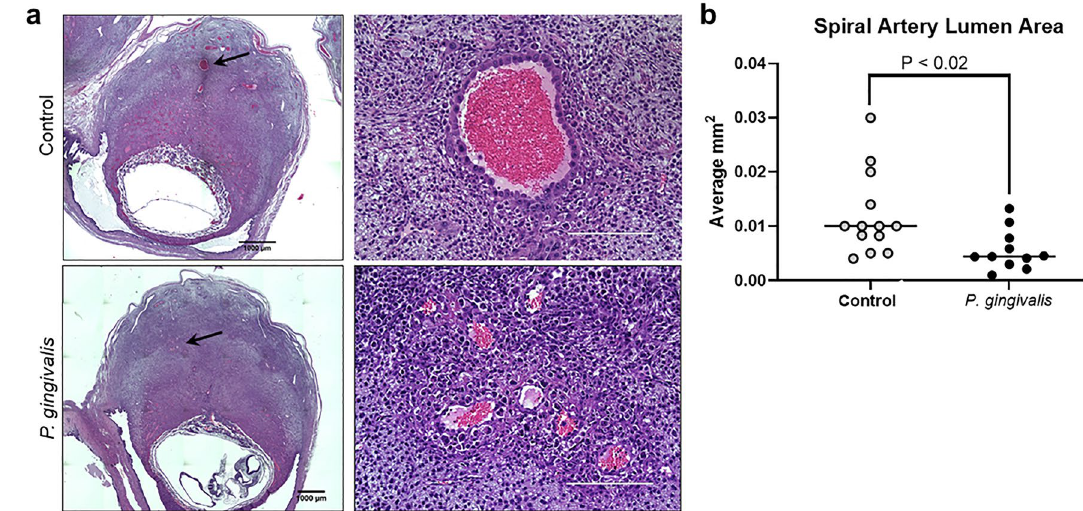
Figure 2. Impact of P. gingivalis infection on GD11 spiral artery lumen size. ( a ) Representative images from control and P. gingivalis -infected specimens. Left panels are tiled composites of individual pictures taken at × 10 magnification with an EVOS Auto FL imaging system. Scale bar = 1000 µm. Black arrows mark the spiral artery segments pictured in the corresponding right panels. White scale bar = 200 µm. ( b ) Spiral artery lumen area measurements from control and P. gingivalis -infected specimens. Horizontal lines indicate the mean ± SD. Data was analyzed by student’s t